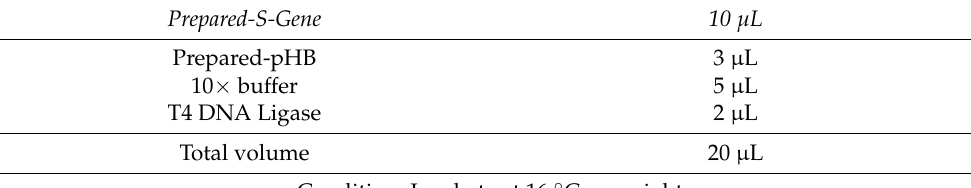
Table 9. The combination conditions for producing pHB-S